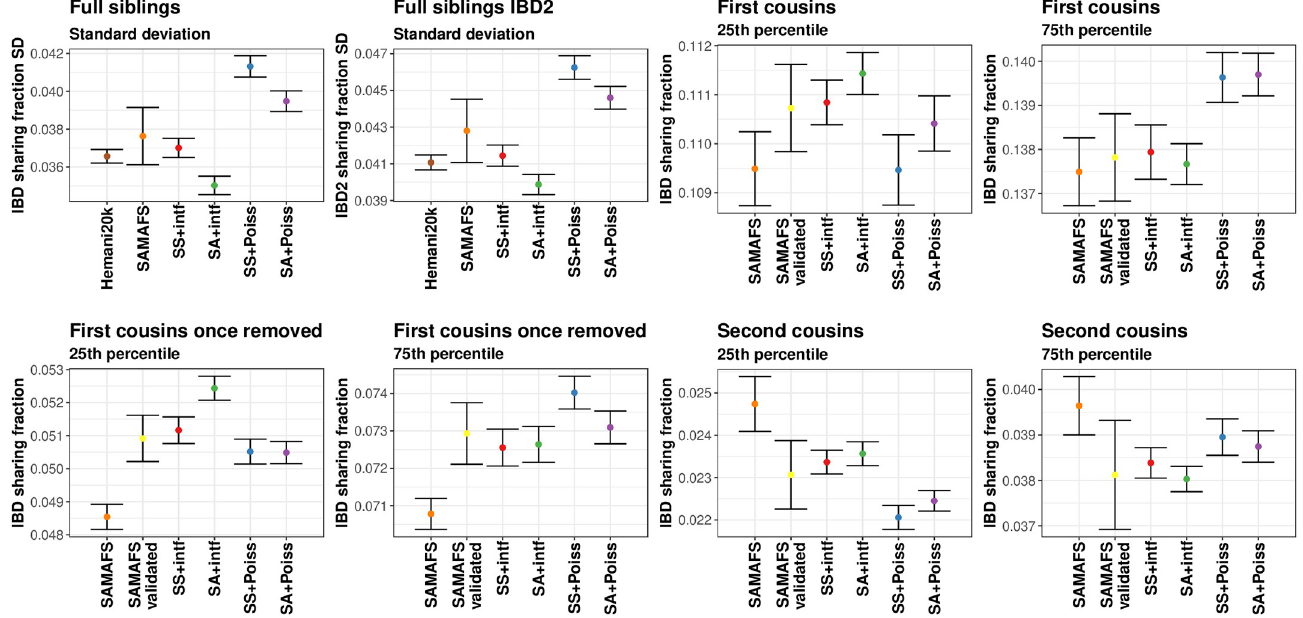
Fig 1. IBD sharing fraction standard deviations in full siblings and 25th and 75th percentiles in first through second cousins from real and simulated data. Points are from the SAMAFS, SAMAFS-validated subset (except full siblings), Hemani20k set (only full siblings), and the simulation models. The latter are labeled using abbreviations given in the main text. The SAMAFS and SAMAFS-validated 25th and 75th percentiles are from values mean-shifted to match expectations. Bars indicate 95% confidence interval ( ± 1.96 standard errors) as calculated from 1,000 bootstrap samples. Standard deviations for first through second cousins and 25th and 75th percentiles for full siblings are in S2 Fig, and further statistics are in S3 Fig. SD indicates standard deviation.